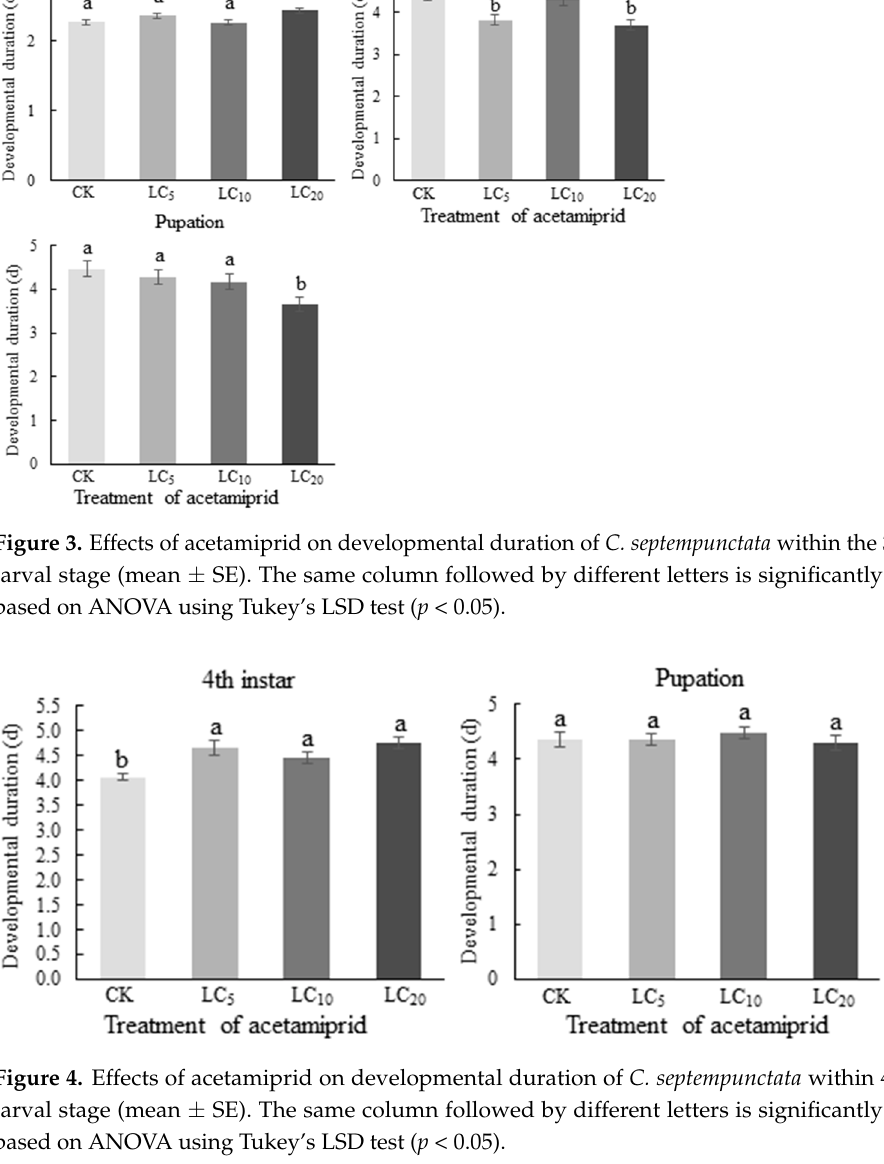
Figure 2. Effects of acetamiprid on developmental duration of C. septempunctata within 2nd instar larval stage (mean ± SE). The same column followed by different letters is significantly different based on ANOVA using Tukey’s LSD test ( p < 0.05).